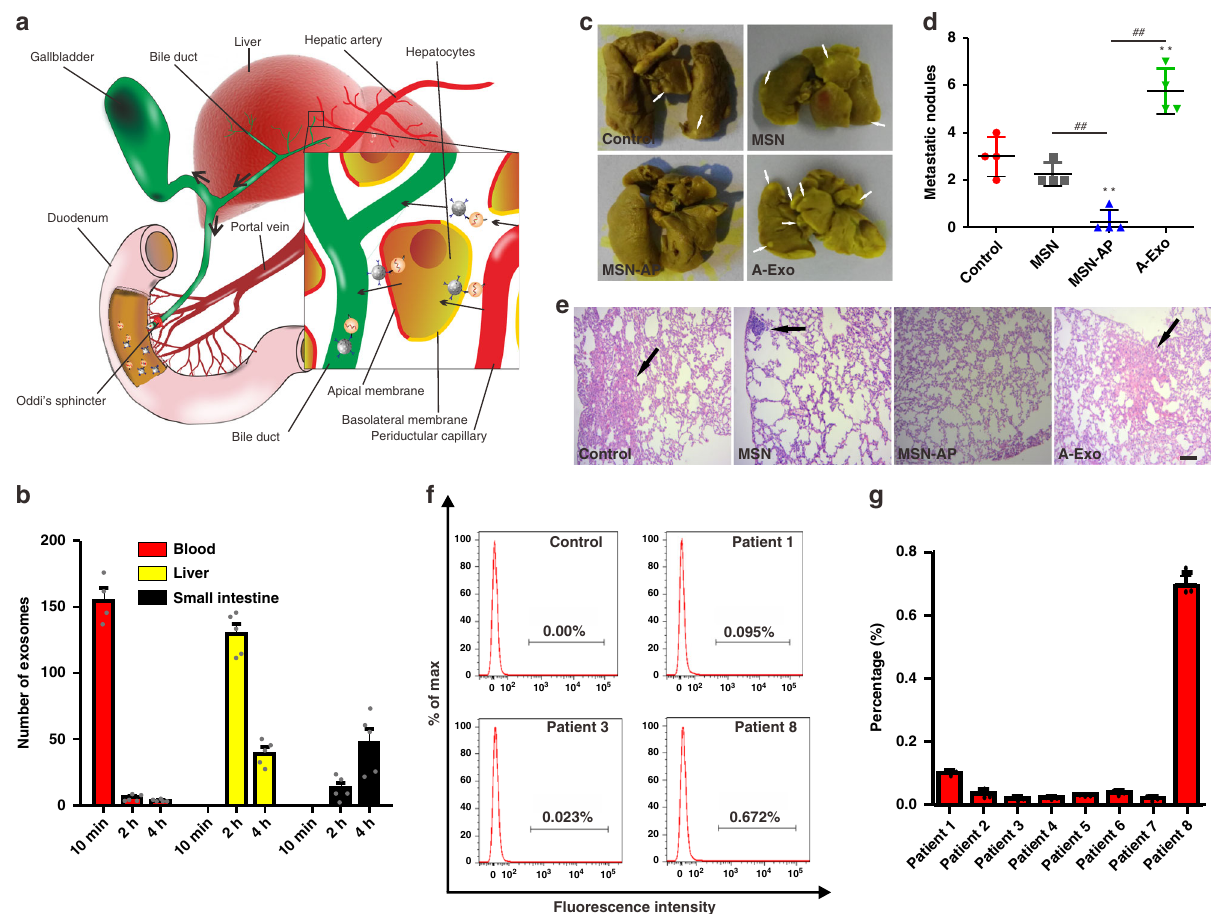
Fig. 6 Elimination or deactivation of circulating exosomes by MSN-AP in animals and patient blood. a Schematic showing that MSN-AP binds to and tows circulating exosomes in the liver into the space of Disse, and the conjugated MSN-Exo can be endocytosed by polarised hepatocytes, transcytosed through the hepatocytes and enter the bile duct and small intestines via the sphincter of Oddi. b Dynamic decrease in blood A-Exo was sequentially accompanied by an increase of A-Exo in the small intestines of mice when MSN-AP was intravenously administered. n = 5. c Photos and d quanti fi cation of lung metastatic nodules developed (arrows) following subcutaneous implantation of A549 cells in nude mice receiving intravenous A-Exo (2 µ g), saline, MSN or MSN-AP (both 5 mg per kg) every 3 days starting on day 14 after A549 implantation for an additional 3 weeks. n = 4 mice. e Lung H&E stains to show tumours. Scale bars: 200 μ m. f Flow cytometry analysis and g quanti fi cation of patient EGFR-exosomes captured by MSN-AP. Note that patient 8 was in a late stage of lung cancer. n = 8 patients. Data presented as the mean ± s.e.m. **, ## , P < 0.01; one-way ANOVA ( d ). The Y -axis of Fig. 6b represents